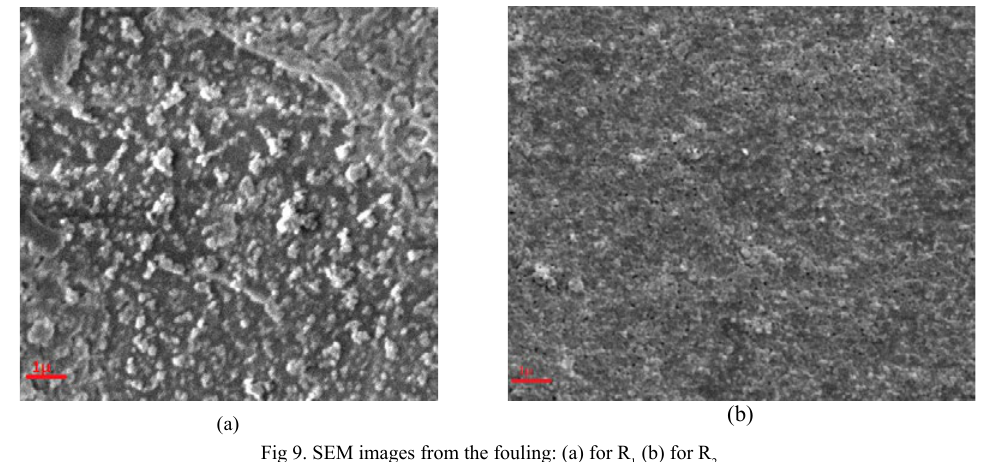
Fig 9. SEM images from the fouling: (a) for R